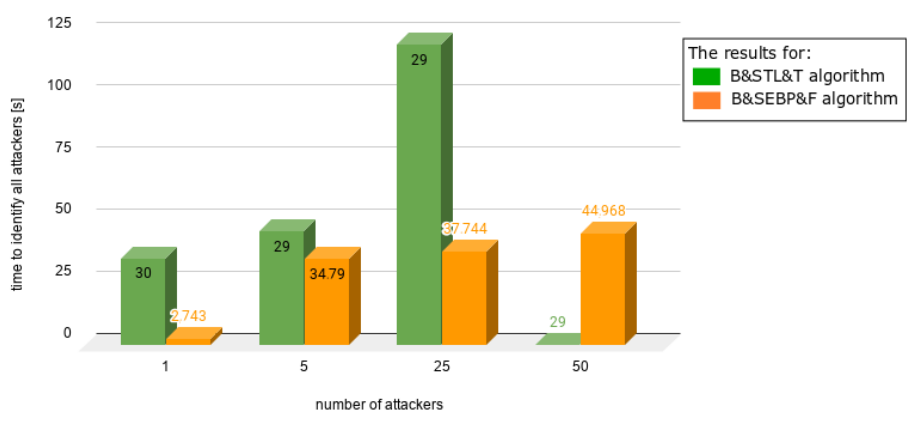
Figure 11. Results from experiments no. 4, 5, 6, and 7 (experiments can be found in Tables 3–7); the graph presents different scenario when the number of users increased significantly as well as number of attackers; the ratios between the attackers and users were 1.96%, 9.05%, 33%, and